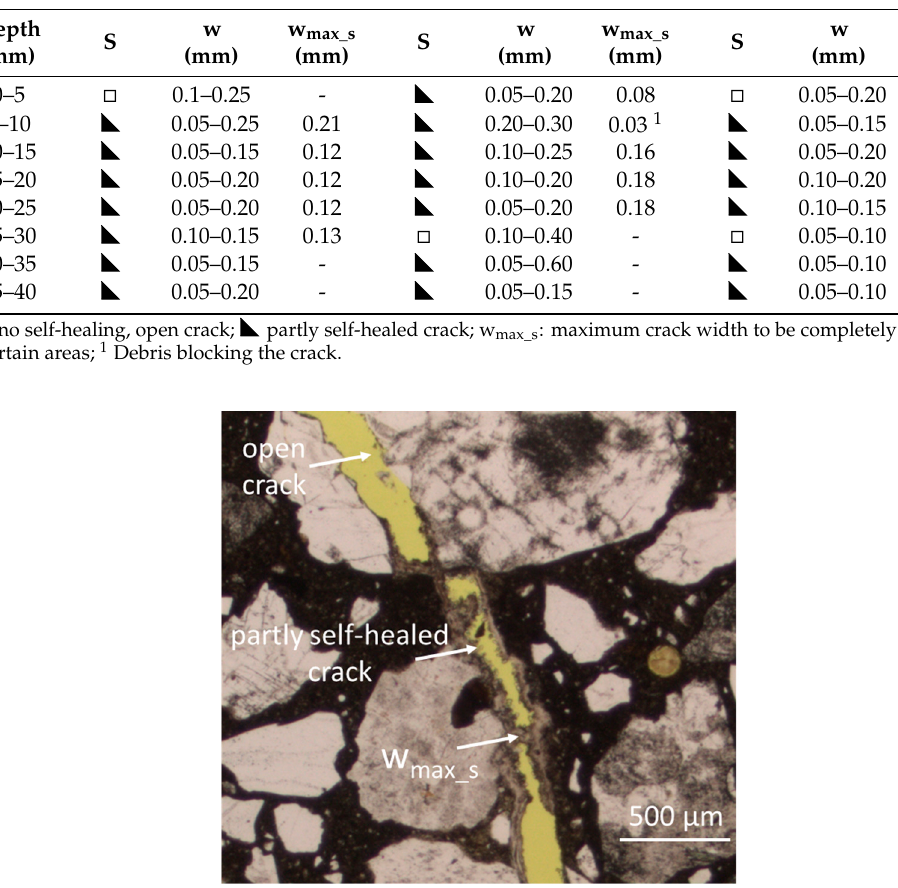
Figure 4. Explanation of the categories ◣ partly self-healed, ☐ no self-healing (open crack) and w max_s used in Table 7.